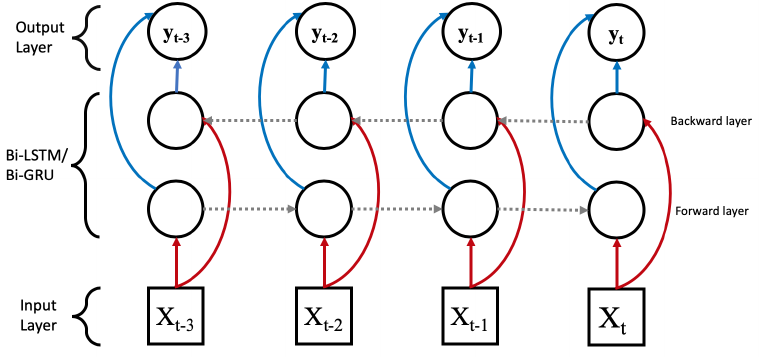
Figure 6. The Bi-LSTM and Bi-GRU are structurally the same except for the LSTM and GRU unit. The red arrows indicate the input value flow, blue arrows are the output values, and the grey arrows represent the information flow between the LSTM/GRU